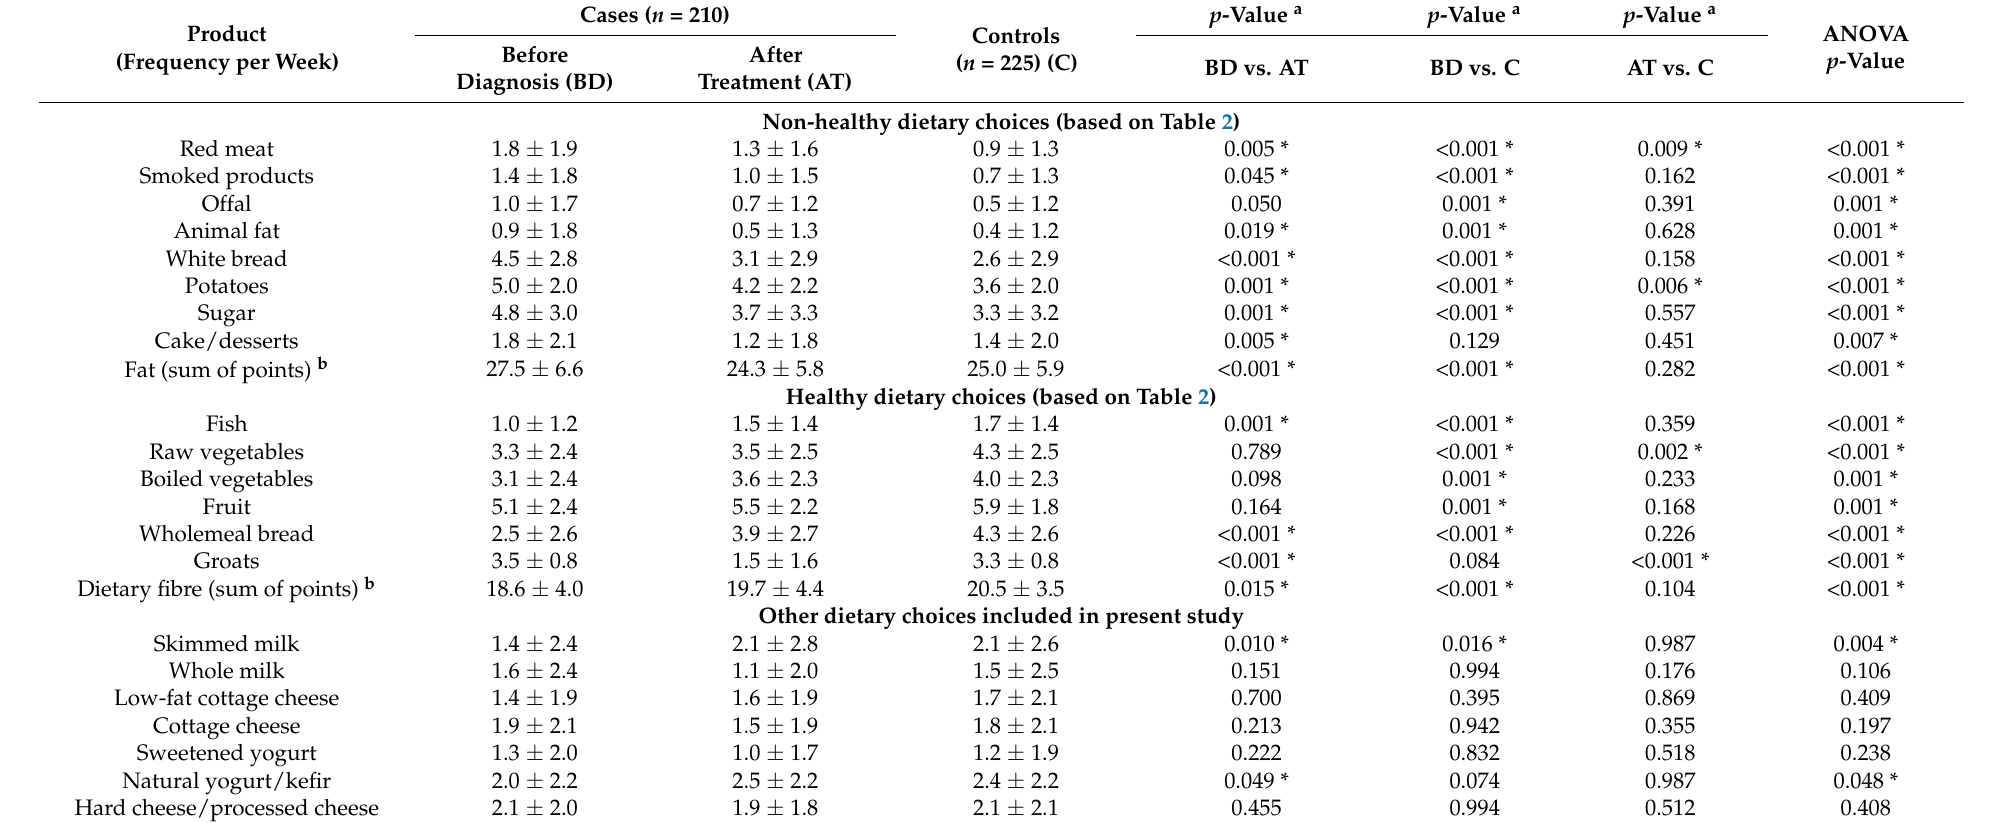
Table 3. Frequency of intake of selected food products by women after